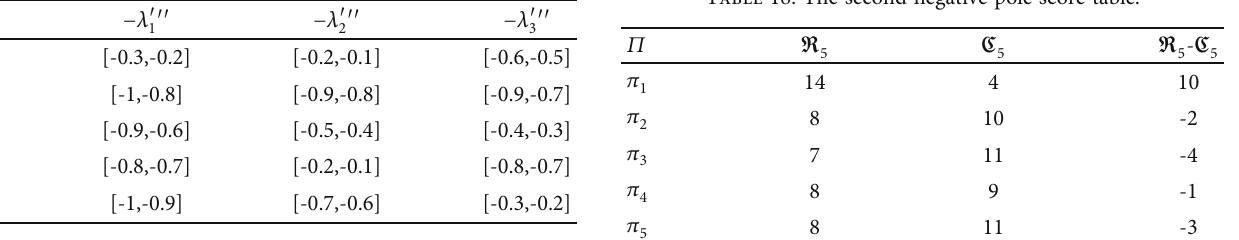
Table 18: The second negative pole score